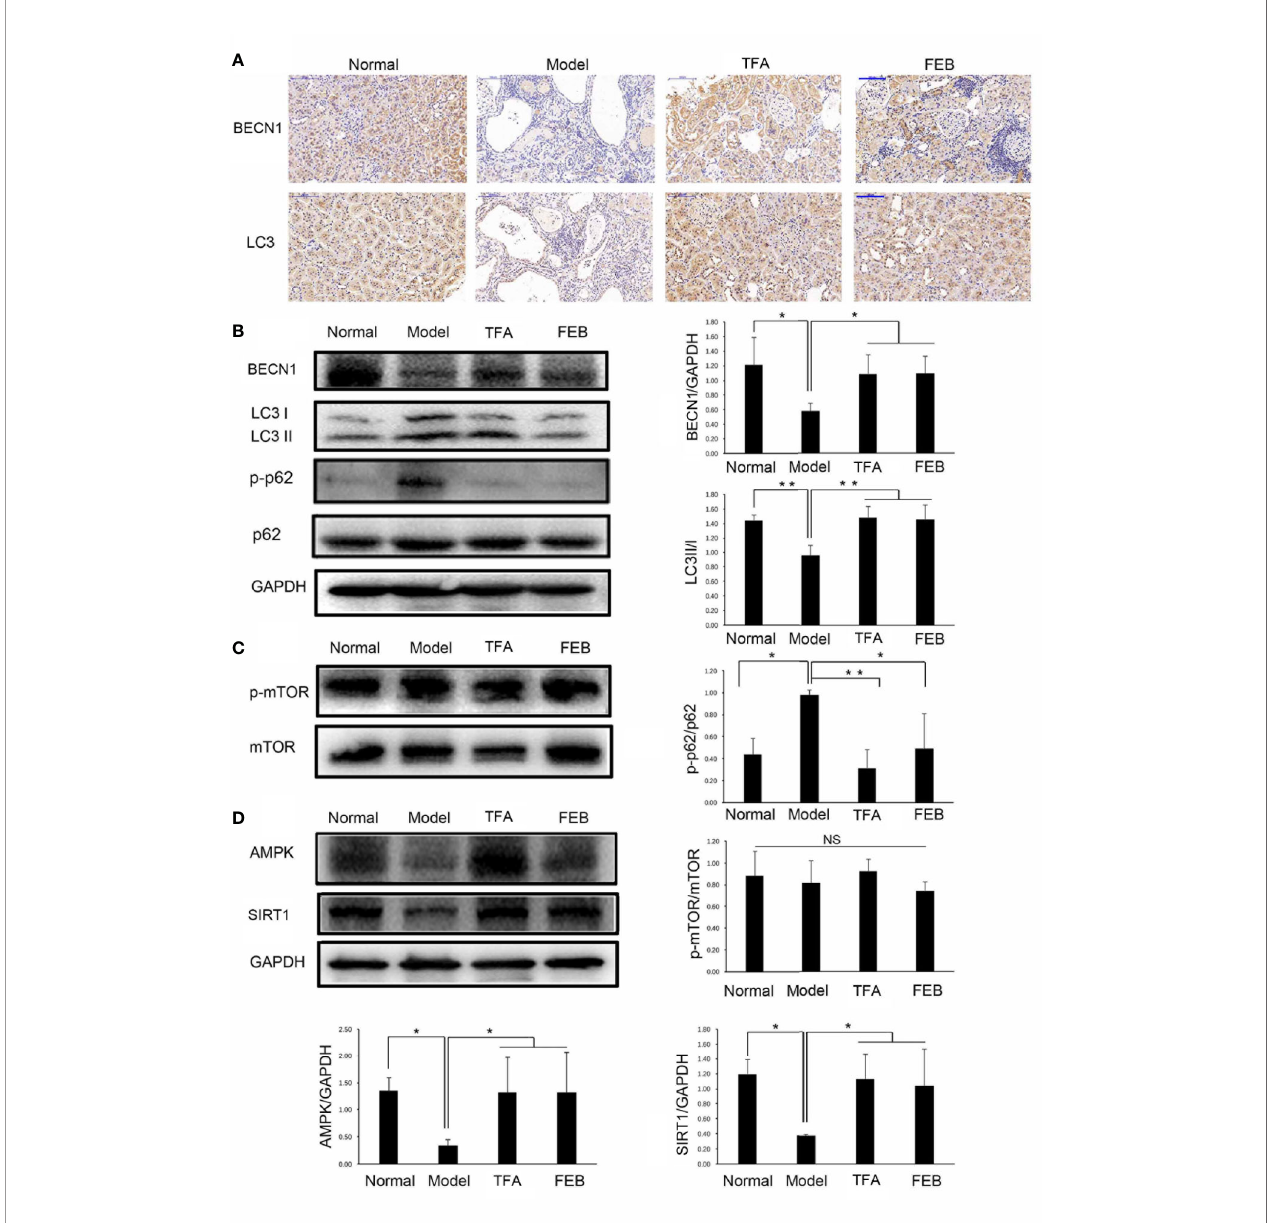
FIGURE 7 | Effects of TFA and FEB on autophagy-mediated macrophage polarization through AMPK-SIRT1 signaling in vivo . (A) Immunohistochemical staining of BECN1 and LC3 in the kidneys of the Normal, Model, TFA, and FEB rats. Scale bar: 100 m m. (B – D) A WB analysis of BECN1, LC3, p-p62, p62, p-mTOR, mTOR, AMPK, and SIRT1 in the kidneys of the Normal, Model, TFA, and FEB rats. The data are expressed as the mean ± SD, (n = 3). * P < 0.05, ** P < 0.01. TFA, total fl avones of Abelmoschus manihot ; FEB, febuxostat; BECN1, beclin1; p-p62, phosphorylated p62; p-mTOR, phosphorylated mTOR; NS, not signi fi cant; WB, Western